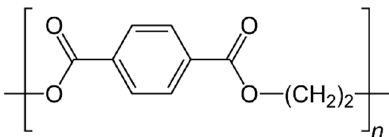
Figure 6. Structure of the polyester backbone.